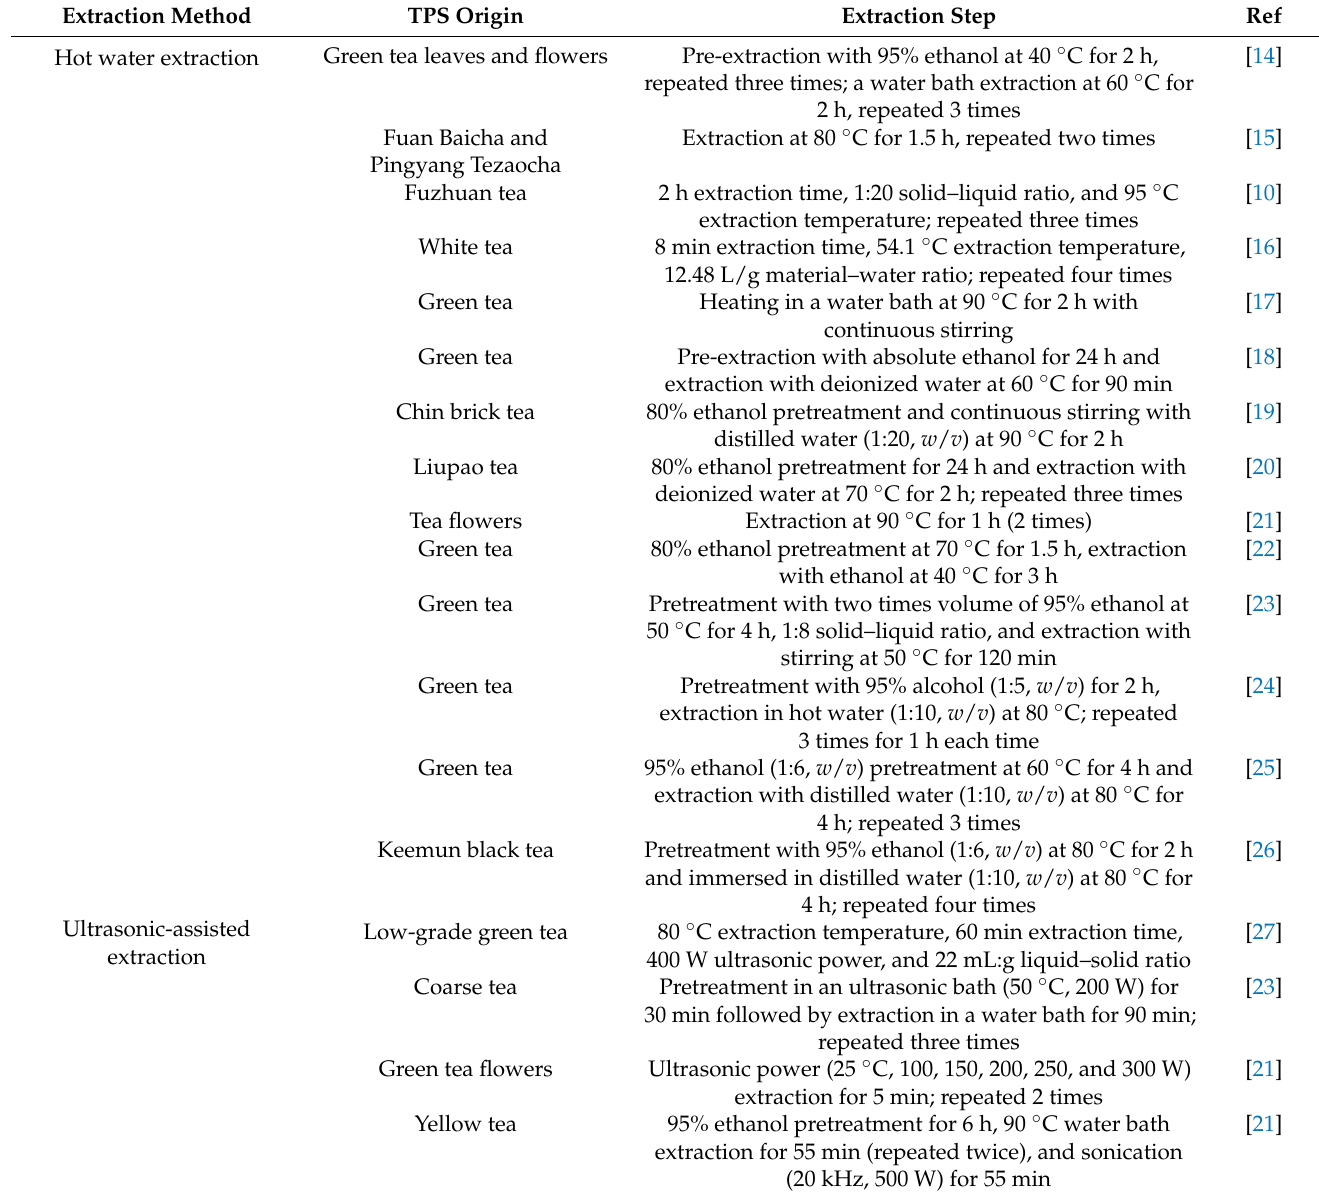
Table 1. Comparison of extraction methods of tea polysaccharide